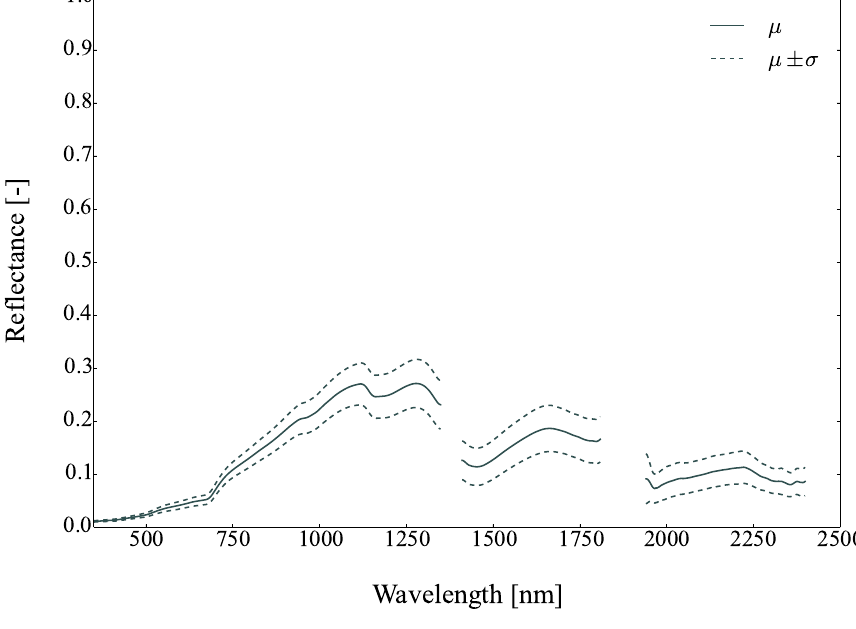
Figure A22. Mean reflectance ( µ ) and standard deviation ( σ ) of Aquatic type c